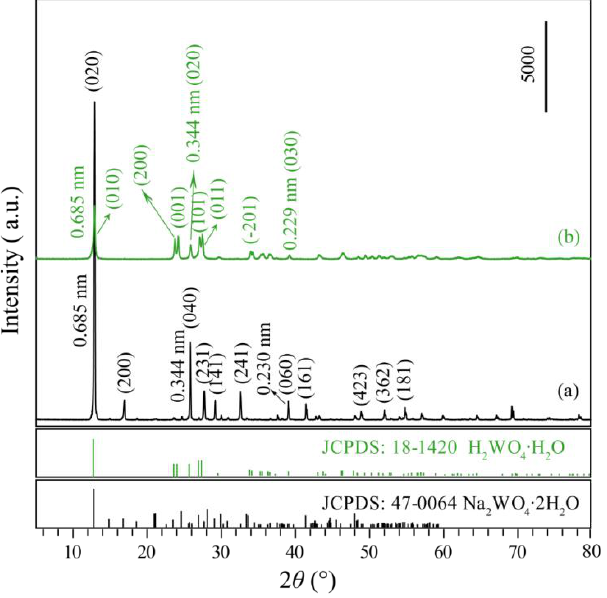
Figure 1. XRD patterns of ( a ) commercial Na 2 WO 4 · 2H 2 O precursor and ( b ) prepared H 2 WO 4 · H 2 O sample.